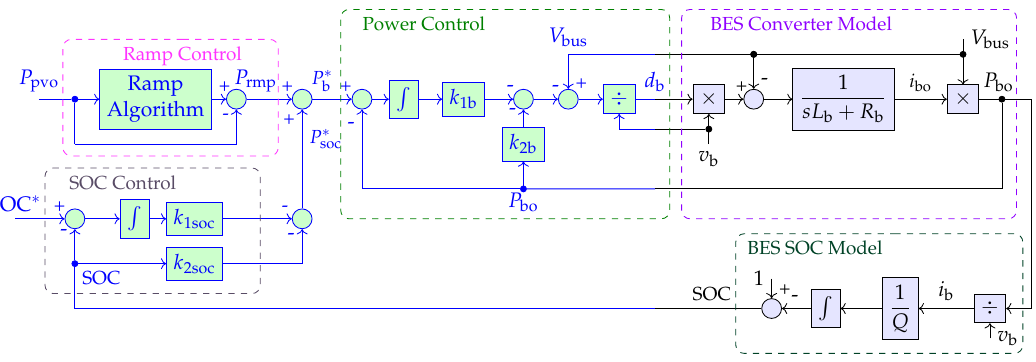
Figure 8. Mathematical model of the BES converter system with the proposed